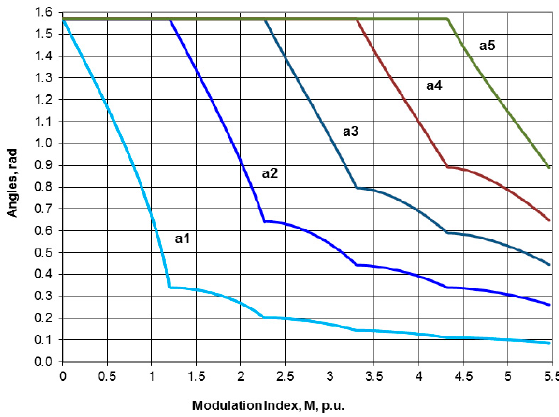
Figure 3. Minimal current THD for n = 5 (up to 11 voltage levels).